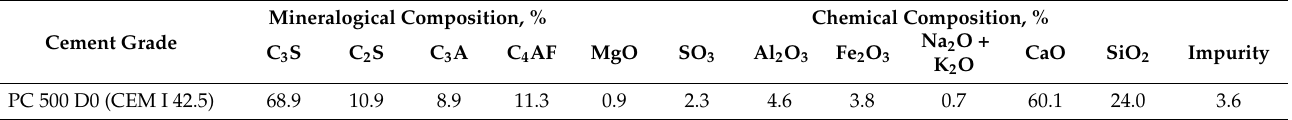
Table 1. Mineralogical and chemical composition of Portland cement.